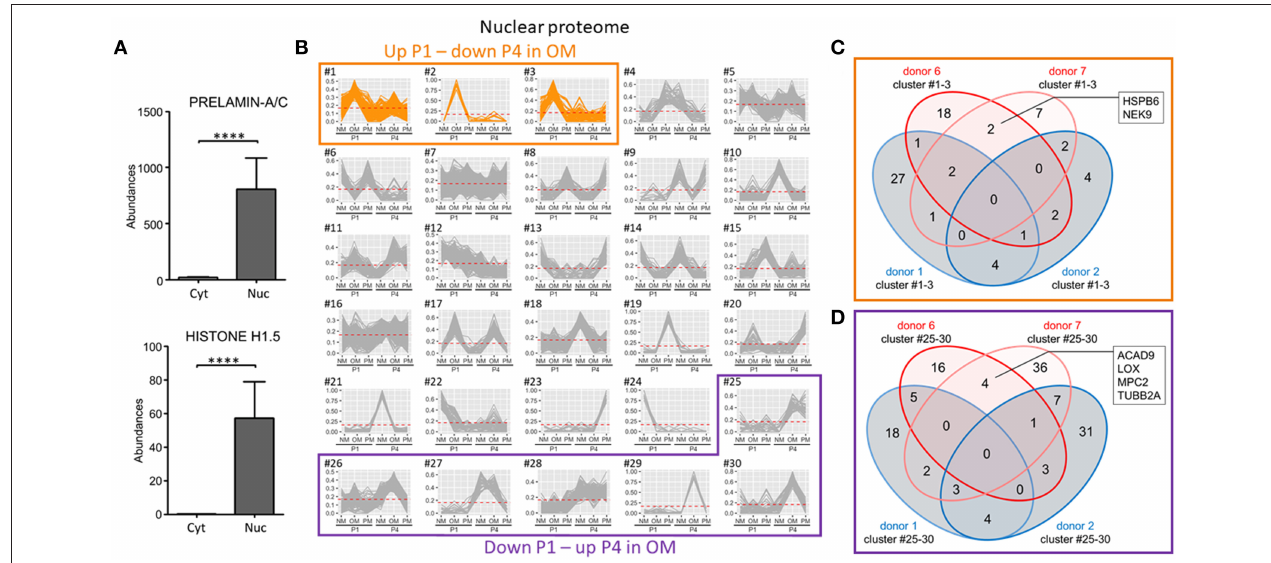
FIGURE 7 | Nuclear-enriched fraction proteomics identified novel proteins associated with VIC calcification in OM. (A) Confirmation of nuclear enrichment using two nuclear markers, prelamin-A/C and histone H1.5; n = 4 donors/fraction, **** P < 0.0001 analyzed by t -test, error bars indicate SD. (B) XINA clustering analysis of protein abundances in NM, OM, and PM. Clusters with increased protein abundance at passage one (P1) and decreased abundance at passage four (P4) in OM indicated (clusters #1–3). Clusters with decreased protein abundance at P1 and increased abundance at P4 in OM indicated by purple box (clusters #25–30); n = 4 donors. (C) Venn diagram showing total number of proteins detected for the four donors analyzed (donors 1, 2, 6, 7) found in the three identified clusters in which abundance is increased at P1 and decreased at P4 in OM. Calcification-prone donors (calcified at P1 in OM; donors 6 and 7) indicated by red color, and calcification-resistant donors (did not calcify at P1 in OM; donors 1 and 2) indicated by blue color. Proteins detected in the three clusters of the two calcification-prone but not in the calcification-resistant donors indicated: heat shock protein family B (HSPB6), NIMA related kinase 9 (NEK9). (D) Venn diagram showing total number of proteins detected for the four donors analyzed (donors 1, 2, 6, 7) and found in the six identified clusters in which abundance was decreased at P1 and increased at P4 in